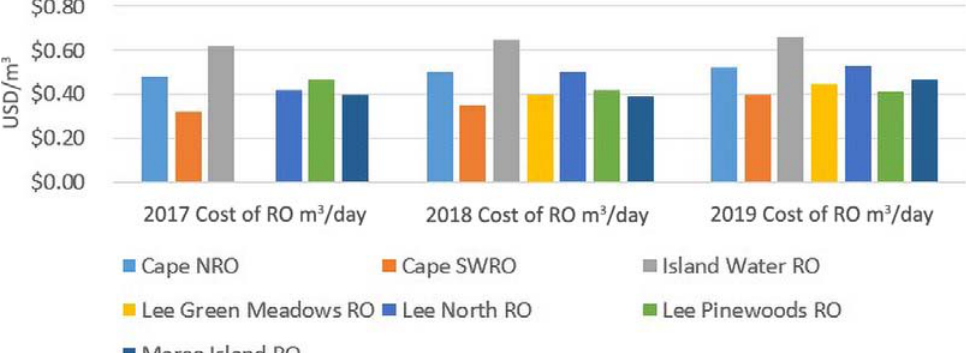
Figure 6. Southwest Florida RO desalination plant cost of water produced in (USD/m³). Note: the Lee County Green Meadows RO Plant began operating in May 2018; therefore, no data were available for 2017 and January–April 2018. Note that the consumer price index for the 3 years was 6.3% or slightly over 2%/year. Table 2. Comparison of capacities, feedwater TDS, range in OPEX over 3 years, and average cost over 3 years. Note that the Lee County Pinewoods Plant has less than 3 years of data. Note that the general increase in cost correlates well with the annual rate of inflation of 2%/year.